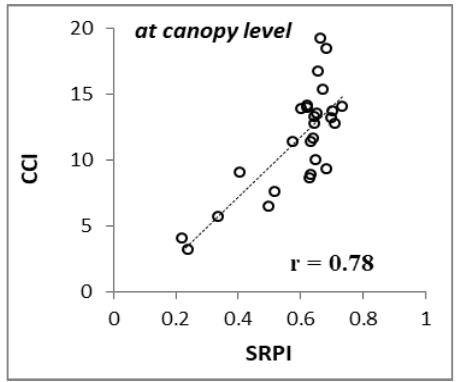
Figure-6 SRPI vs